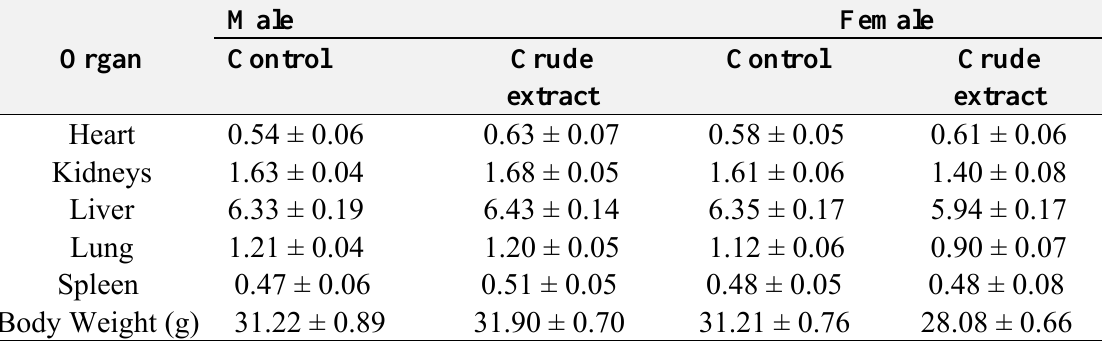
Table 3. Effect of Elaeis guineensis crude extract on organ-to-body weight index (%) in